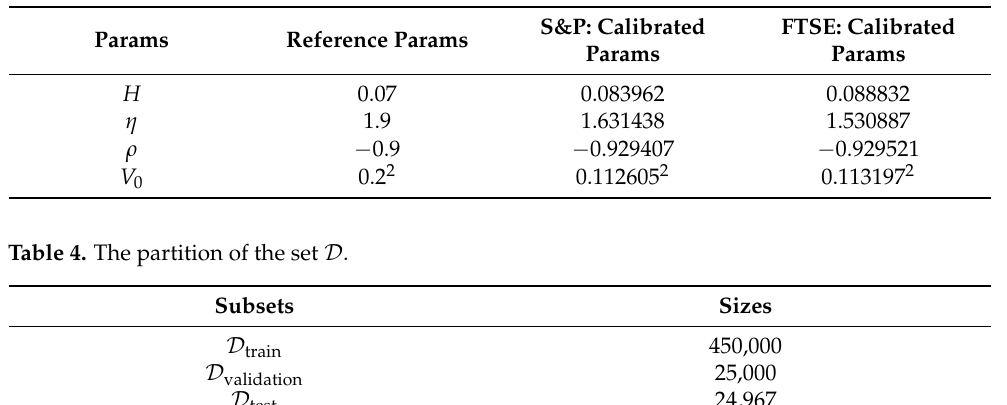
Table 3. Reference parameters and calibrated parameters for the rBergomi model.